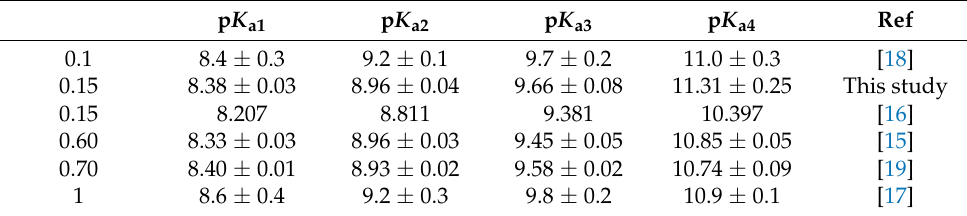
Figure 2. Mass spectra of Zr-DFO complex by Nano-ESI-Q-MS. ( a ) Entire spectrum from m / z = 500 to 1000. ( b ) Enlarged view of the mass spectra at the range from m / z = 615 to 620. ( c ) Isotope distribution of ZrH 3 DFO 2 Na 2+ species. ( d ) Nano-ESI-Q-MS/MS spectra from the precursor ion of m / z = 1229.571. A disassembled peak ( m / z = 647.23) was observed. Table 1. The log p K ai of DFO (1 ≤ i ≤ 4) obtained at various ionic strengths I (mol/L) of